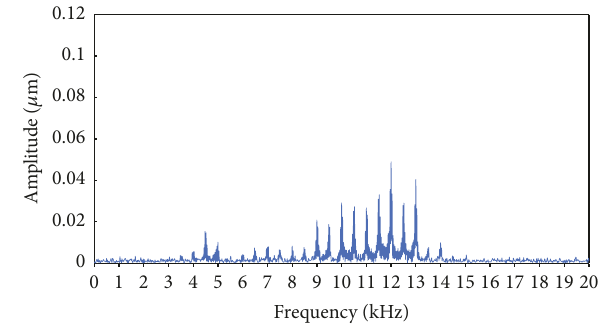
Figure 42: Spectrum of the residual signal obtained for the second scenario (two consecutive cracked teeth with 30% CLP).